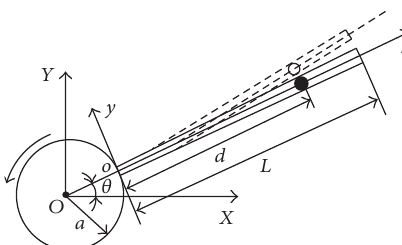
Figure 1: Rigid-flexible beam coupling system with concentrated